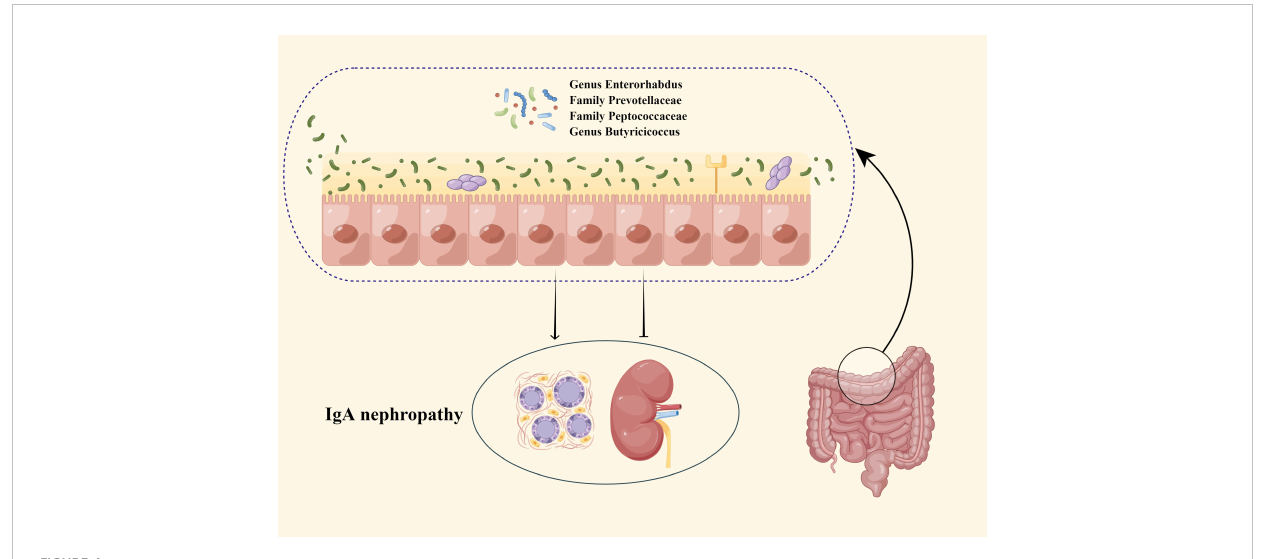
FIGURE 4 The present MR study reveals that GM may causally in fl uences